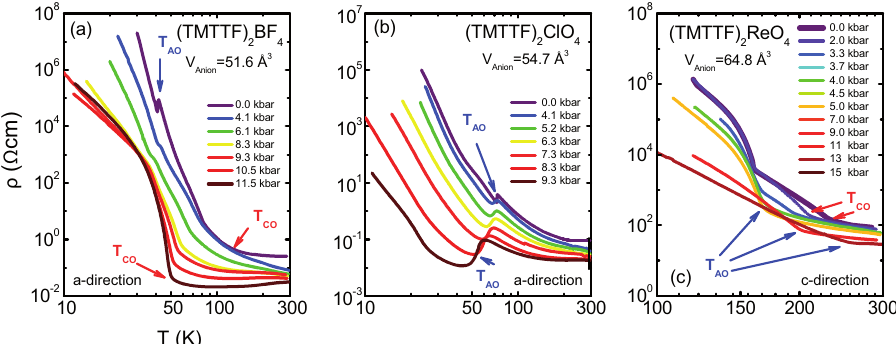
Figure 16. The temperature dependent resistivity for the (TMTTF) 2 X salts with tetrahedral anions. The three compounds are sorted for increasing anion size from left to right. ( a ) (TMTTF) 2 BF 4 is the compound with the smallest anion: V Anion = 51.6 Å 3 . It shows both transitions in the dc resistivity, charge and anion ordering. ( b ) In (TMTTF) 2 ClO 4 with V Anion = 54.7 Å 3 only anion ordering was detected but no separate charge order. ( c ) (TMTTF) 2 ReO 4 has by far the largest tetrahedral anion with V Anion = 64.8 Å 3 ; it also has the highest charge and anion ordering temperatures.